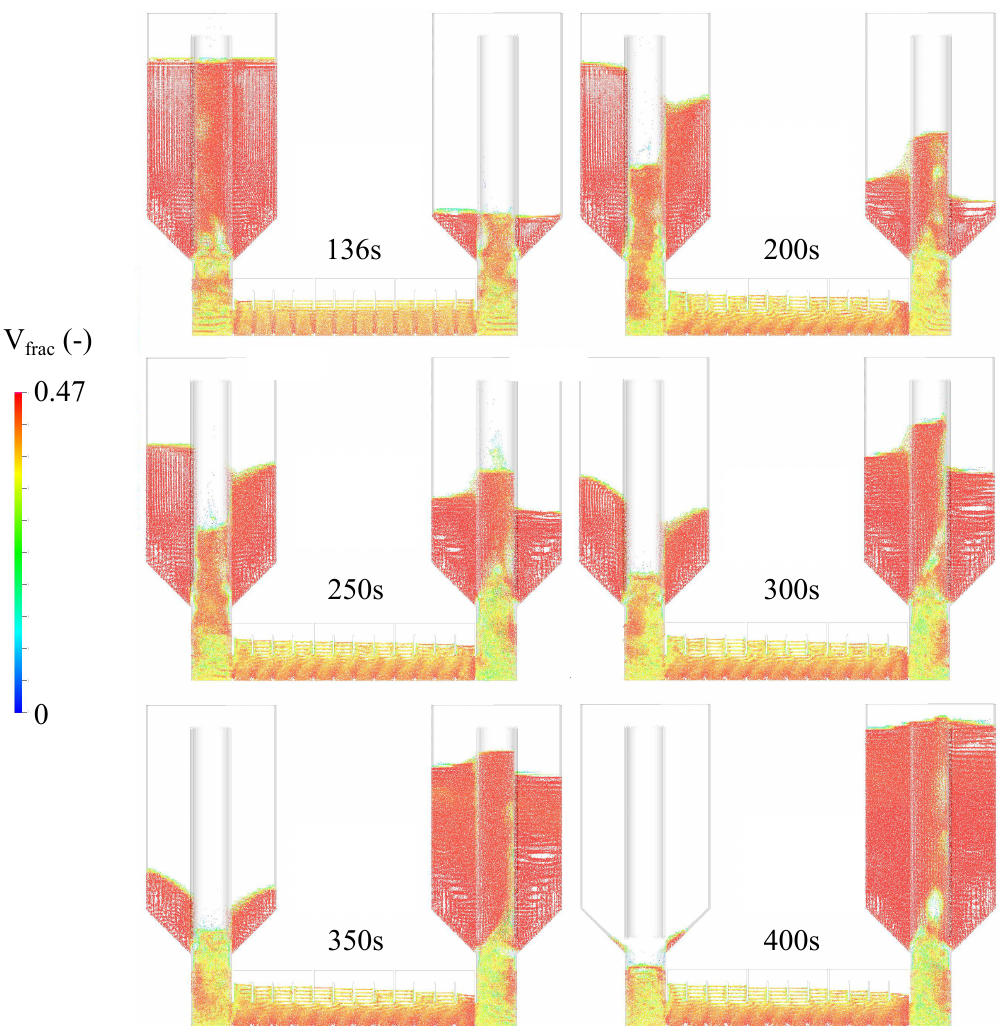
Figure 17. Pipe 4—Transport of a whole hopper volume and total emptying of the left hopper at controlled goodmass flows of ≈ 3 kg/s, respectively, ≈ 0.7 kg/s